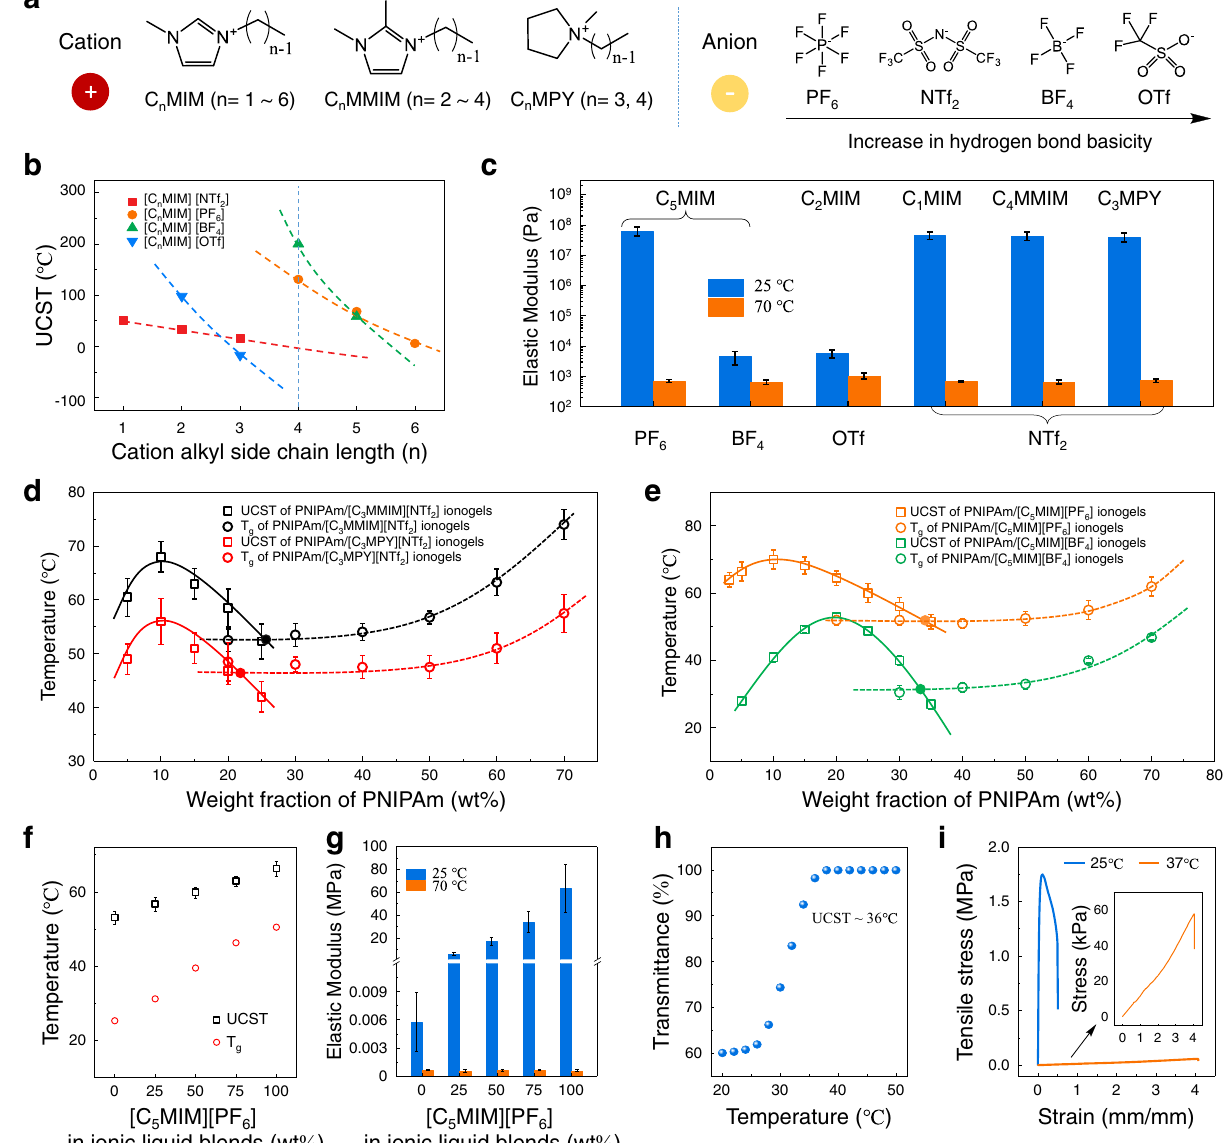
Fig. 3 | StructuraleffectsofILsontheBerghmans ’ point. a Molecularstructures ofcationsandanionsofILsusedinthiswork. b UCSTofionogelswithrespecttothe molecular structure ILs. c Mechanical characterization of PNIPAm ionogels using different ILsassolvent with elastic modulus extractedfrom the initialstress – strain curves (the UCST of ionogels from left to right are 66.3°C, 53.2°C, 98°C, 51°C, 52°C and 47°C, respectively). d Effect of cation in ILs on the phase diagram of the ionogels. e EffectofanioninILsonthe phase diagramof the ionogels. f Tuningthe UCST and T g of the ionogels by varying the mixing ratio of anions in ionic liquids